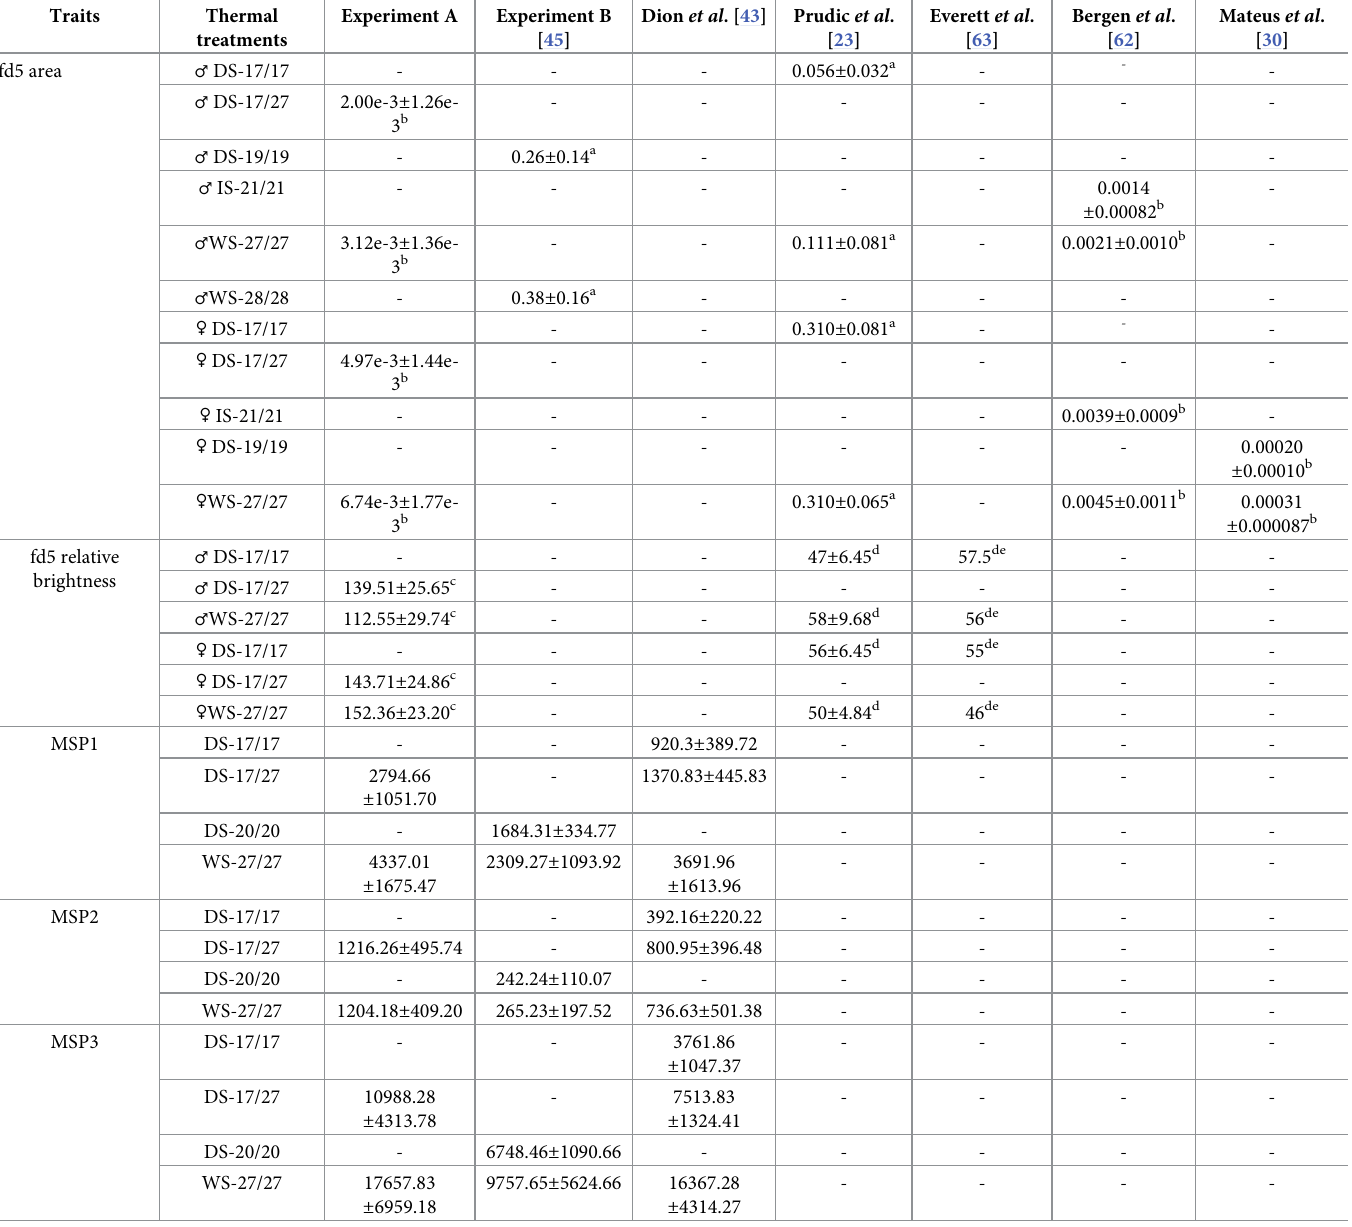
Table 3. Comparison of sexually-selected traits between dry and wet season phenotypes using this and other studies. Traits Thermal treatments